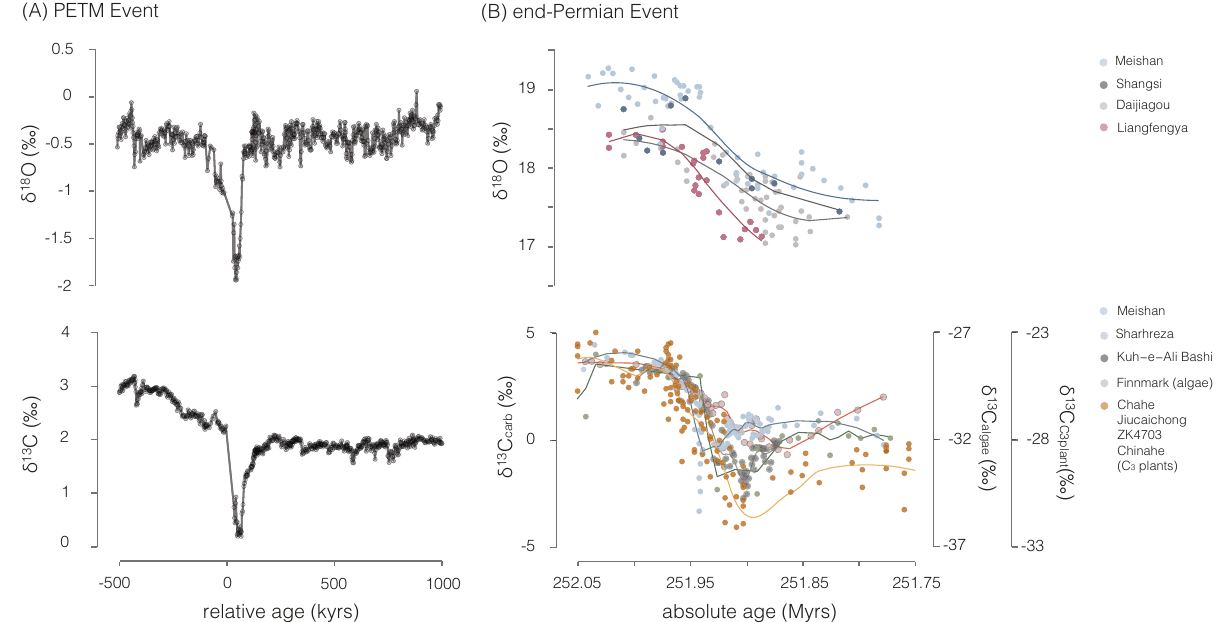
Fig. 2 Carbon and oxygen isotope records. Carbon-isotope ( δ 13 C) and oxygen isotope ( δ 18 O) records across the ( A ) Paleocene – Eocene Thermal Maximum (PETM; ODP Site 1262) and ( B ) end-Permian. Latest Permian and Early Triassic δ 13 C archives include carbonate 32,88,89 , algae 8 , and plant matter 4 . Negative carbon-isotope excursions are traditionally interpreted to mark the release of isotopically light carbon, while oxygen isotopes are used as a paleo-temperature proxy and are measured in conodont elements for the end-Permian event and in biogenic carbonate (planktonic foraminifera and coccoliths) for the PETM 2,3,32,90 . The PETM exhibits tight stratigraphic covariation between the δ 13 C and δ 18 O isotope excursions, in contrast to end- Permian records.